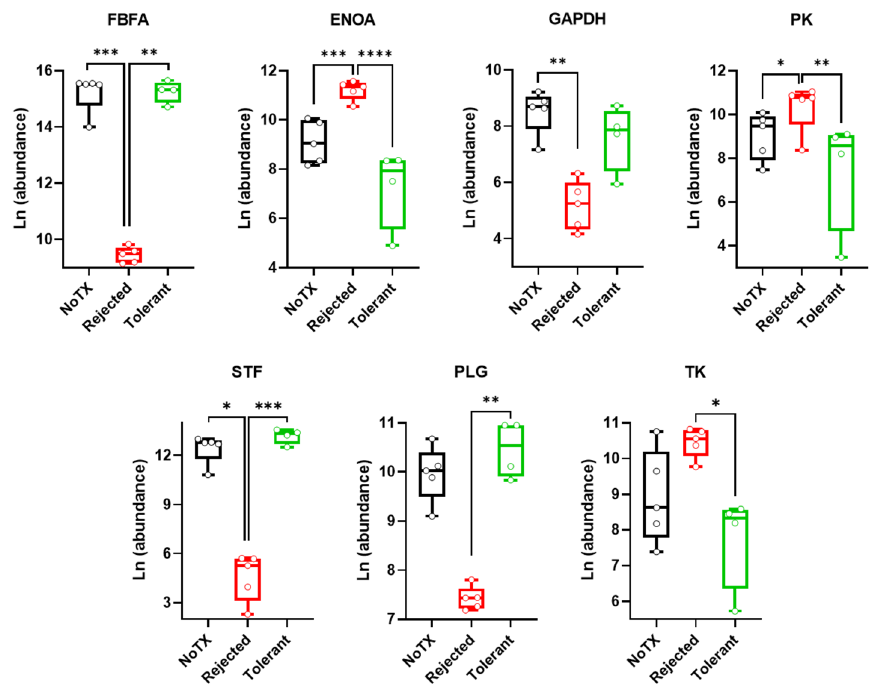
Figure 3. Relative abundance of proteins related to the Warburg effect measured in aqueous humor (AQH) samples of non-transplanted controls (NoTX; black) and transplant recipient mice that either rejected (red) or tolerated (green) their intraocular islet allografts. Relative abundance values were log-transformed using the natural log (Ln), and data were shown as box and whisker plots indicating the medians (horizontal lines in each box) and the upper and lower quartiles with all data points shown as open round symbols corresponding to each sample from one mouse ( n = 5 mice for NoTX; n = 5 mice for rejected; and n = 4 mice for tolerant). Asterisks denote significant difference by ANOVA followed by Tukey’s multiple comparison test with * p < 0.05; ** p < 0.001; *** p < 0.0001; **** p < 0.00001 (see Table